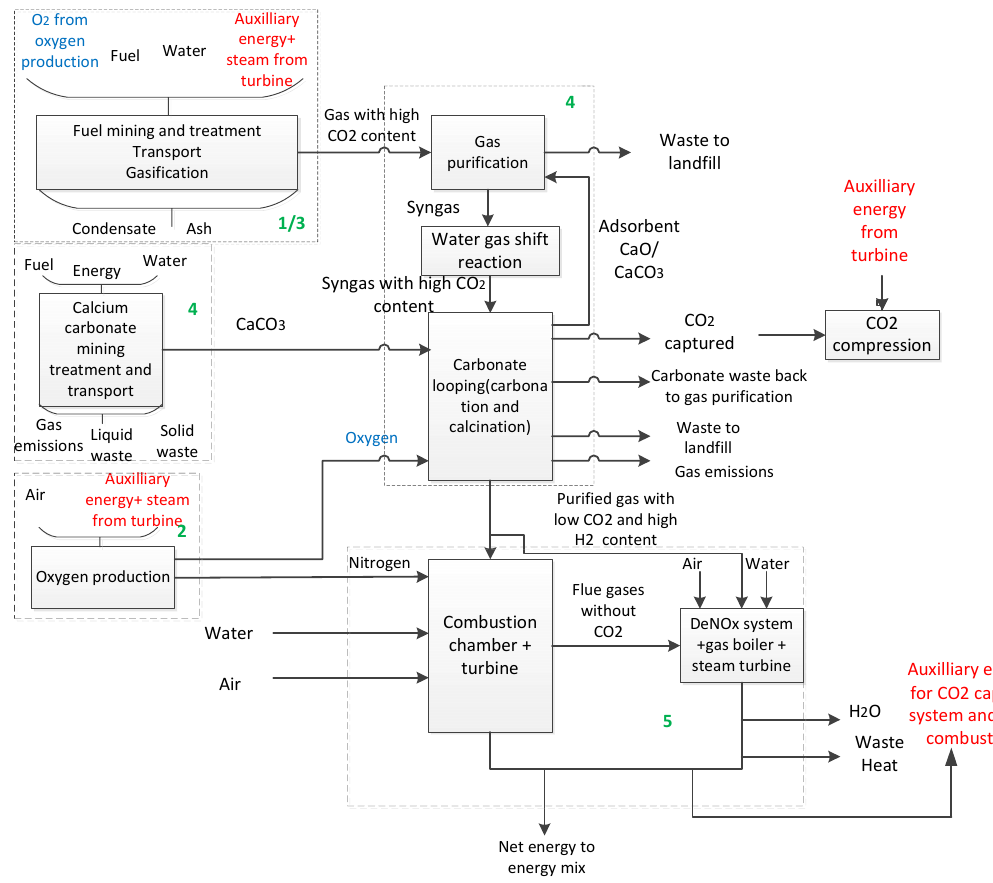
Figure 1. System boundaries for Scenario 1 (marked red are energies returning back to the system; dashed lines with numbers represent technological segments).